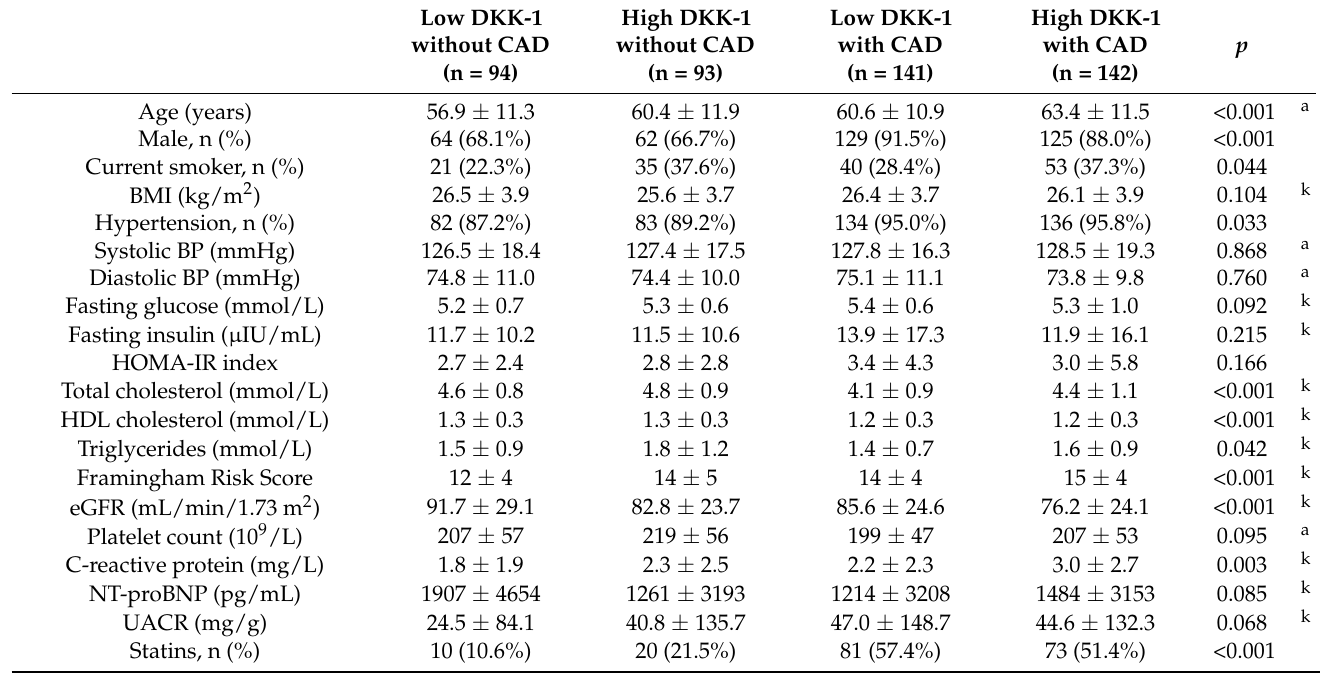
Table 1. The baseline characteristics of enrolled patients categorized by CAD and median plasma